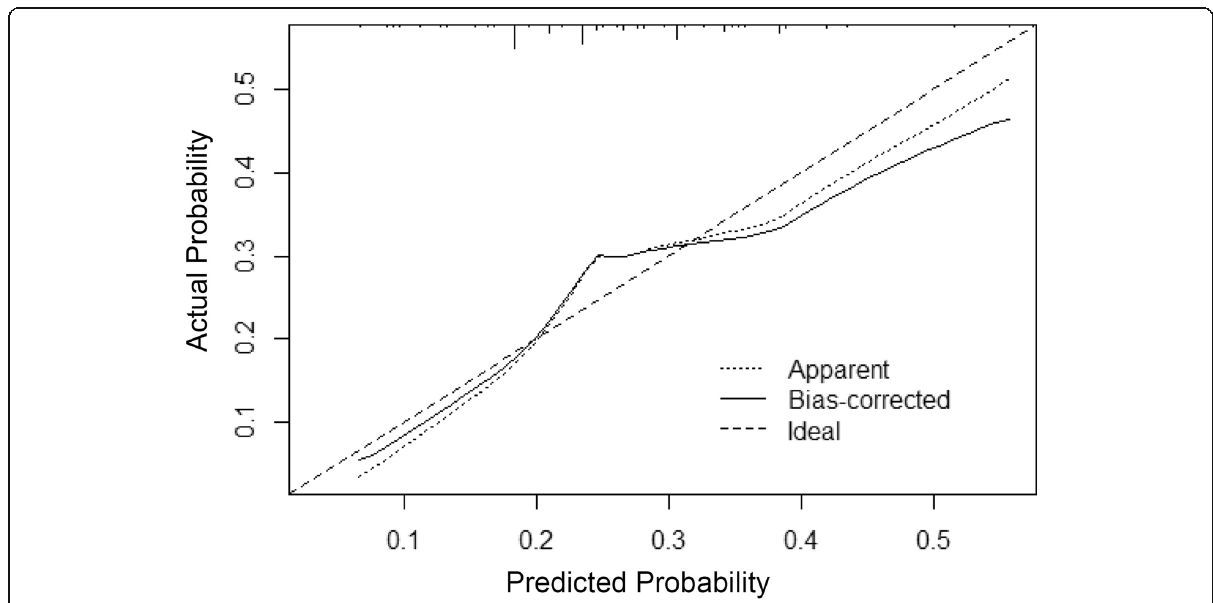
Fig. 4 Calibration plots of the nomogram for the probability of HER2 positive breast cancer (bootstrap 1000 repetitions)